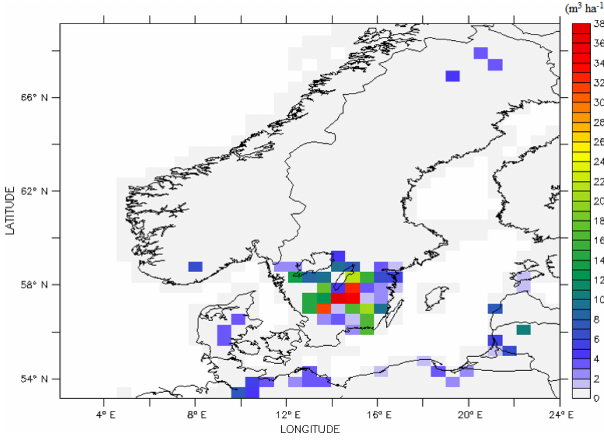
Figure 7. The case study of the storm Edwin (Gudrun) on 8 Jan- uary 2005. The colour scale shows the damaged woody volume (m 3 ha − 1 ) due to this event.